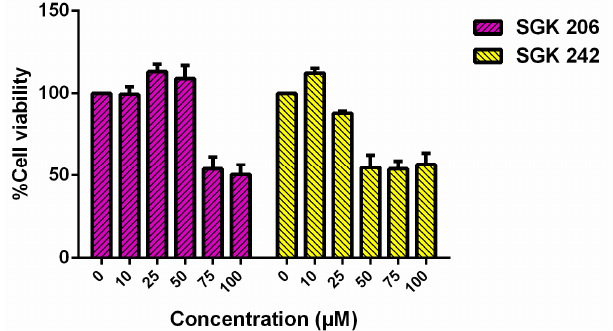
Figure 3. Cell viability assay results of HT-29 cell line for different concentrations of SGK 206 and SGK 242 (0–100 μ M) following 24 h